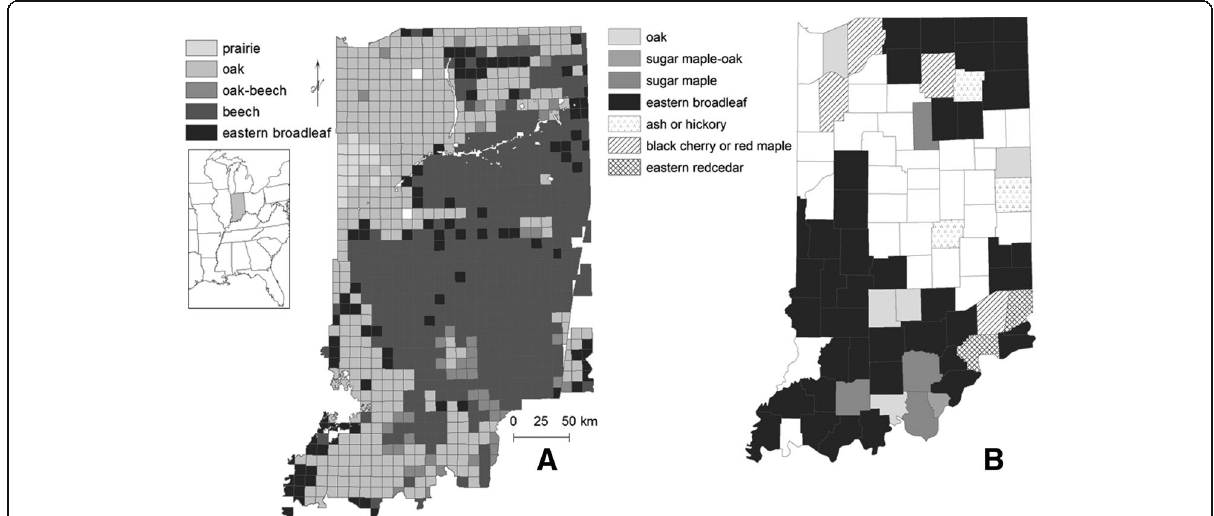
Fig. 1 Historical forest types (composition ≥ 24% by township; rare oak-hickory and beech-sugar maple re-classified as oak or beech, respectively) of Indiana (panel a ). Any township without a species or genus ≥ 24% was classed as eastern broadleaf forest. Current forest types (species or oaks, hickories, and ashes ≥ 24% by county) of Indiana (panel b ). Any county without species or oaks, hickories, and ashes ≥ 24% was classed as eastern broadleaf forest. Counties without 100 trees (white) were excluded. Despite different areas for townships and counties, sample size was about 215 trees in townships and 335 trees in